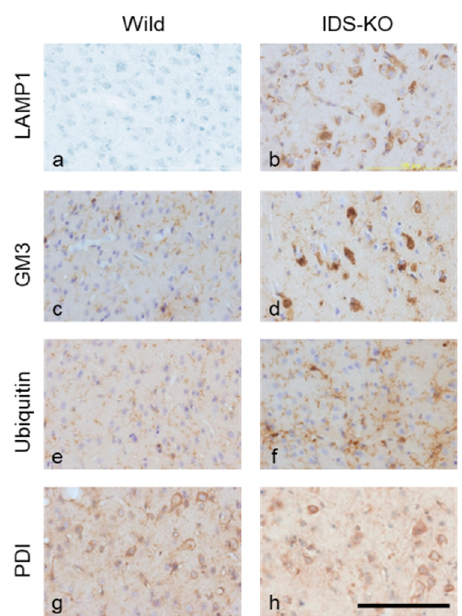
Figure 5. Immunostaining of the cerebral cortex for lysosomal associated protein 1 (LAMP 1; a and b), GM3 (c and d), ubiquitin (e and f), and protein disulfide isomerase (PDI; g and h). Panels a, c,